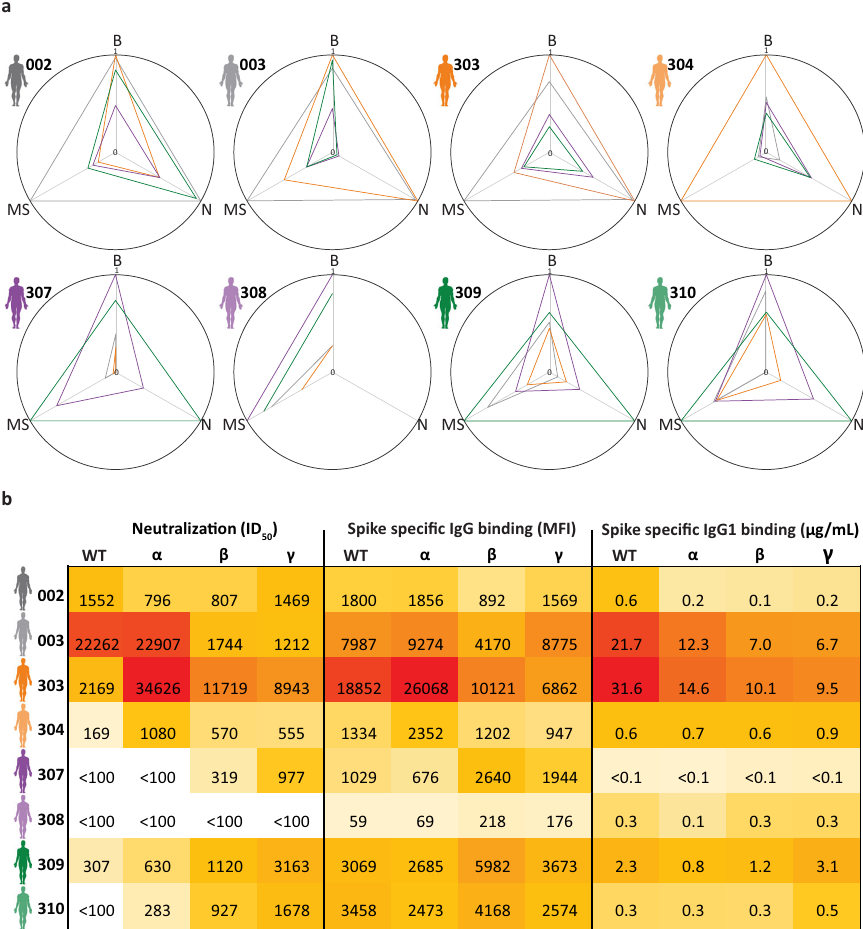
Fig. 4 | Properties of antigen speci fi c IgG(1) repertoires and correlation between different binding and neutralization assays. a each radar plot repre- sentsdataforasingledonor,withaxisrepresentingdataoftheneutralizationassay (N),S-proteinspeci fi ctotalIgGbindingassay(B)andS-proteinspeci fi cIgG1binding by LC – MS (MS). Per axis and per donor, the values are normalized based on the highestvalueobservedforthataxisforthatspeci fi cdonor,givingavalue1withthe other values displaying the proportion of this highest base value, i.e. in between 0 and1.EachlinerepresentsdataagainstaparticularS-protein(shownwiththecolor